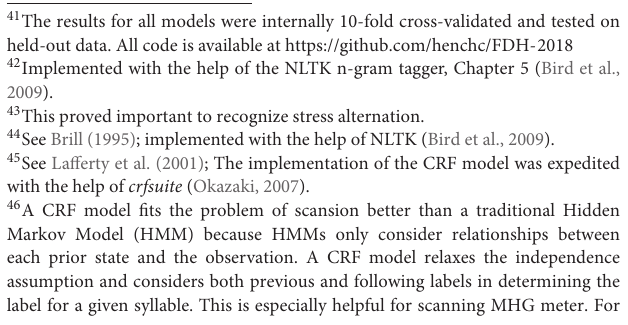
FIGURE 1 | Flow chart for MHG scansion.